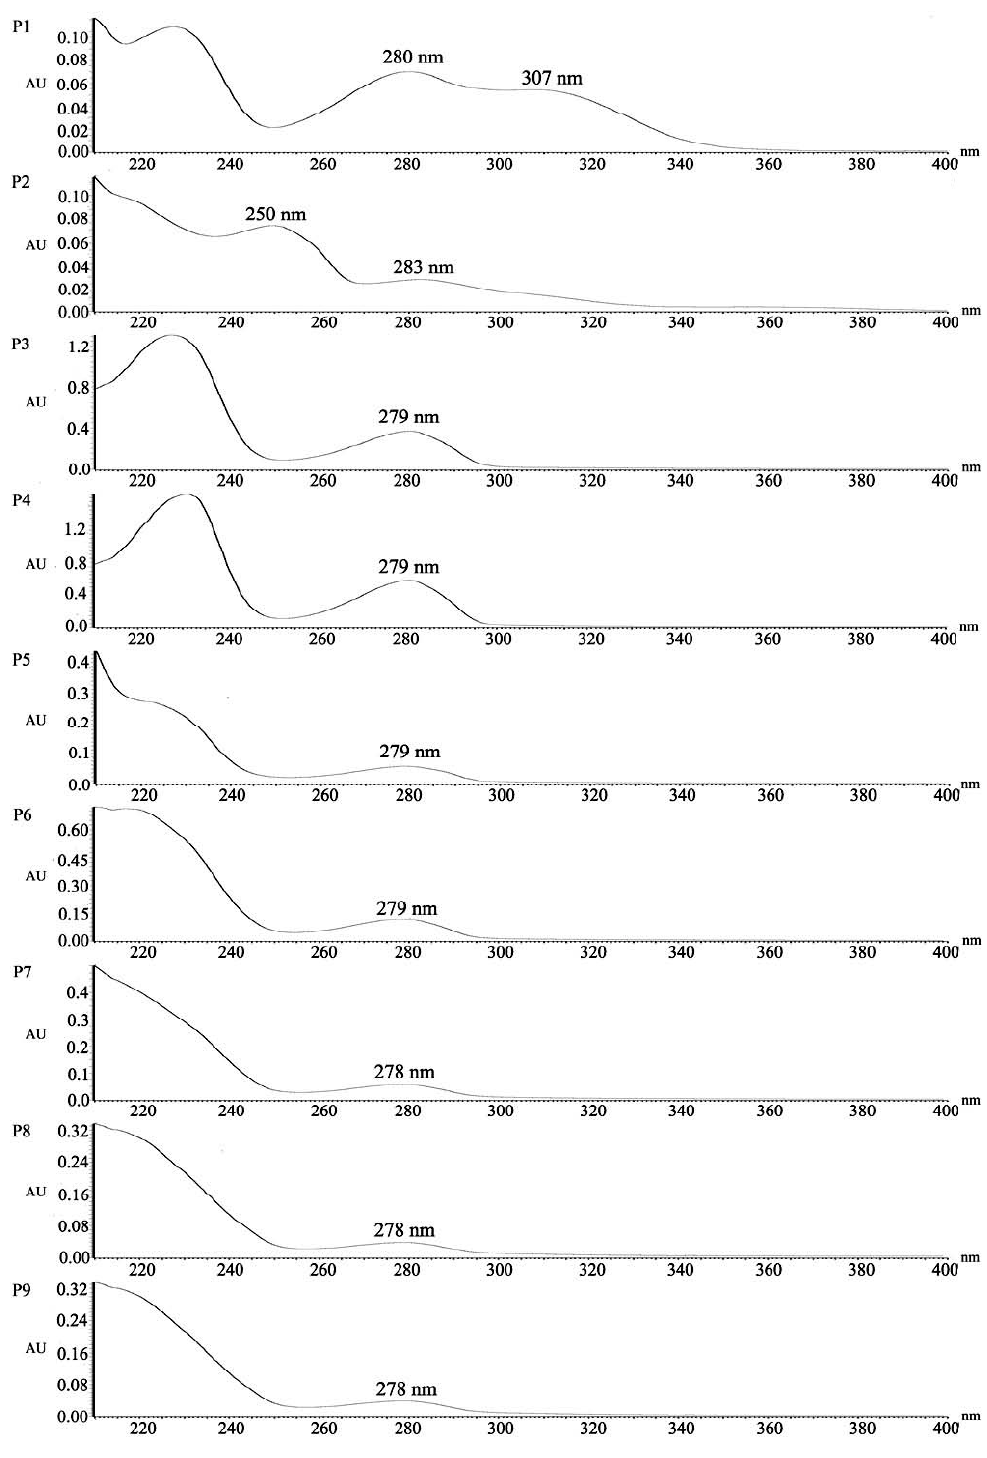
Figure 5. The ultraviolet (UV) spectra of Compounds P1-9.